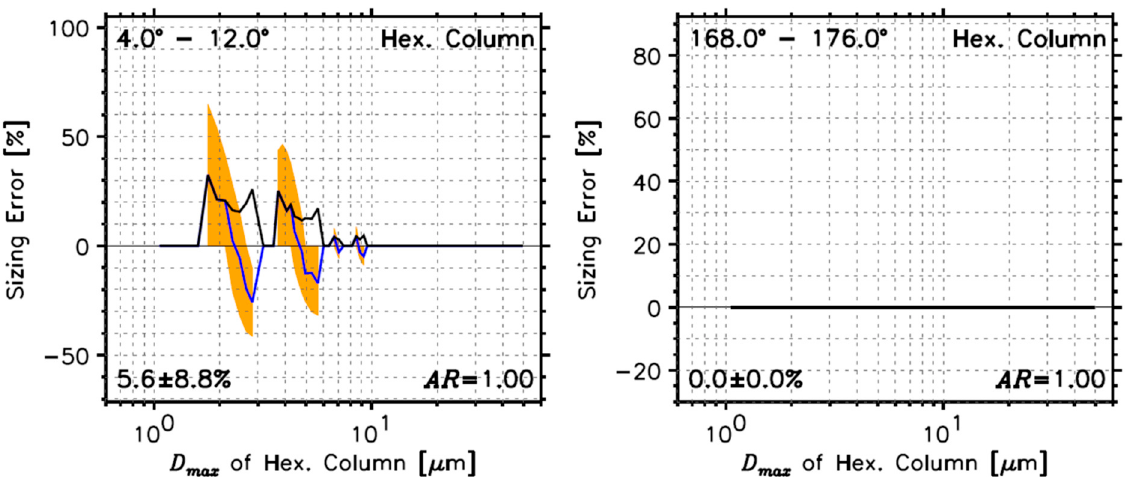
Figure 11. Determined sizing errors of hexagonal ice crystals in forward (4°–12°, left ) and backward (168°–176°, right ) directions. The sizing errors are calculated using an exact comparison between the measured D max of hexagonal ice crystals and those calculated by the ADDA assuming hexagonal ice crystals with aspect ratio of 1.0. The color scheme is the same as Figure 6.